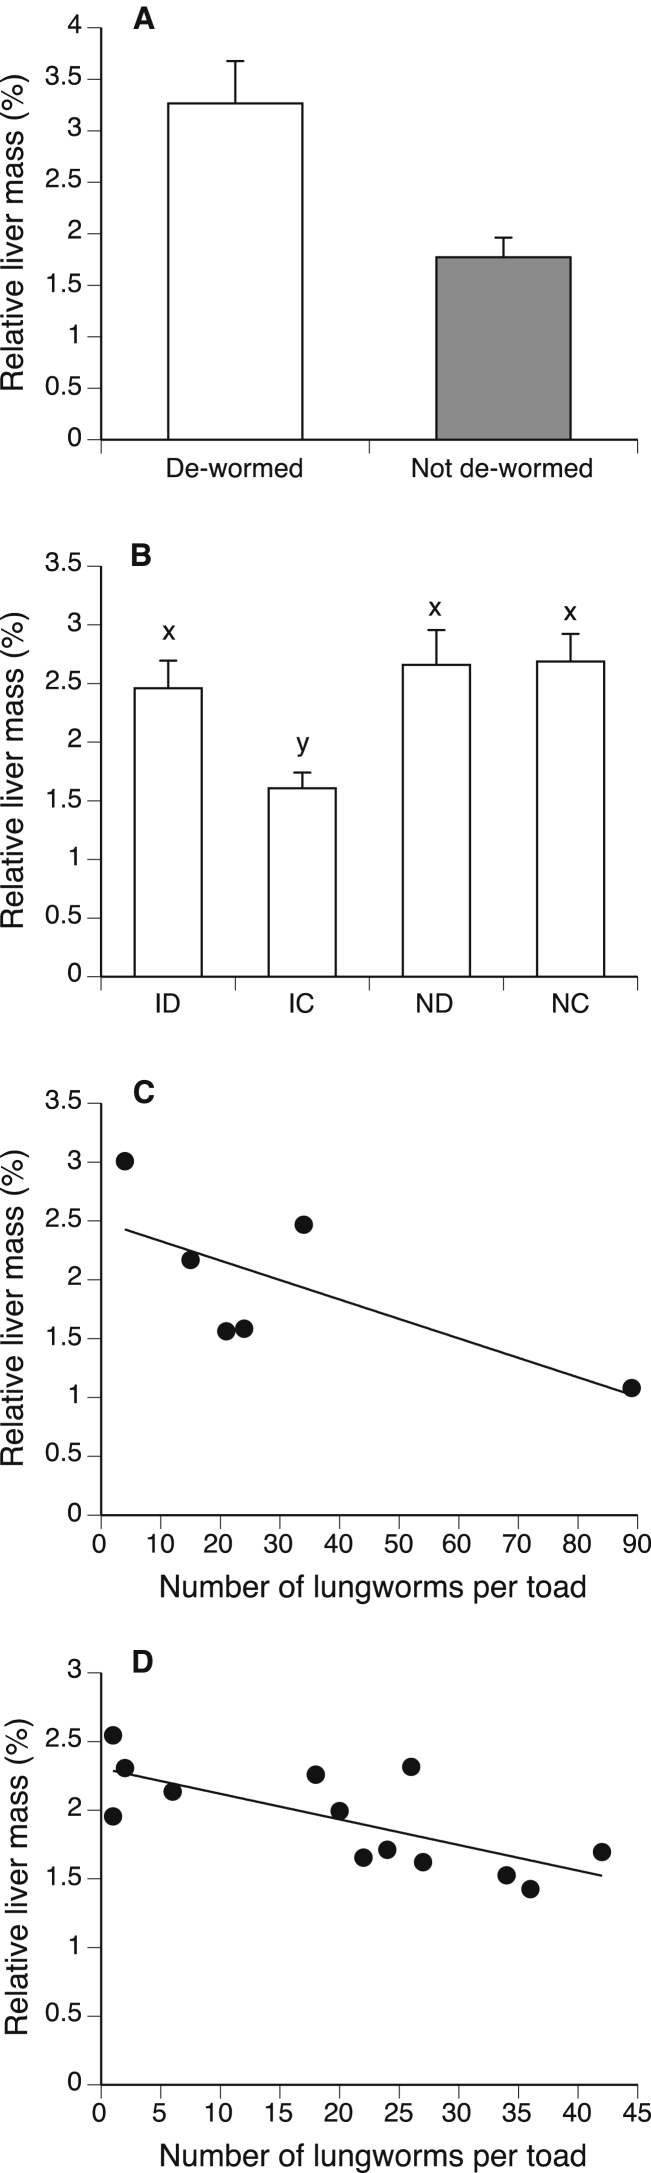
(A) The effects of anthelmintic treatment on relative liver mass of 5 de-wormed (open bars) vs. 6 not de-wormed (grey bars) free-ranging toads. (B) Effect of experimental treatment on relative liver mass of 49 captive cane toads. ID = infected, de-wormed (n = 11), IC = infected, control (n = 13), ND = non-infected, de-wormed (n = 13), NC = non-infected, control (n = 12). (C) Effect of Rhabdias infection intensity on relative liver mass of 6 free-ranging non-de-wormed toads. (D) Effect of Rhabdias infection intensity on relative liver mass of 13 infected captive cane toads given a control dose of amphibian ringers (IC). Bars show mean values ± 1 SE. Bars with the same alphabetical superscript are not significantly different from one another (p > 0.05).